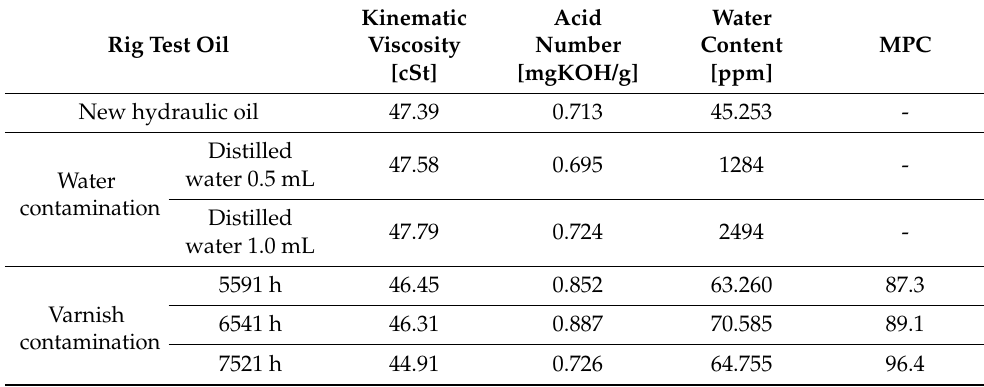
Table 6. The oil analysis results of water and varnish contamination for the rig